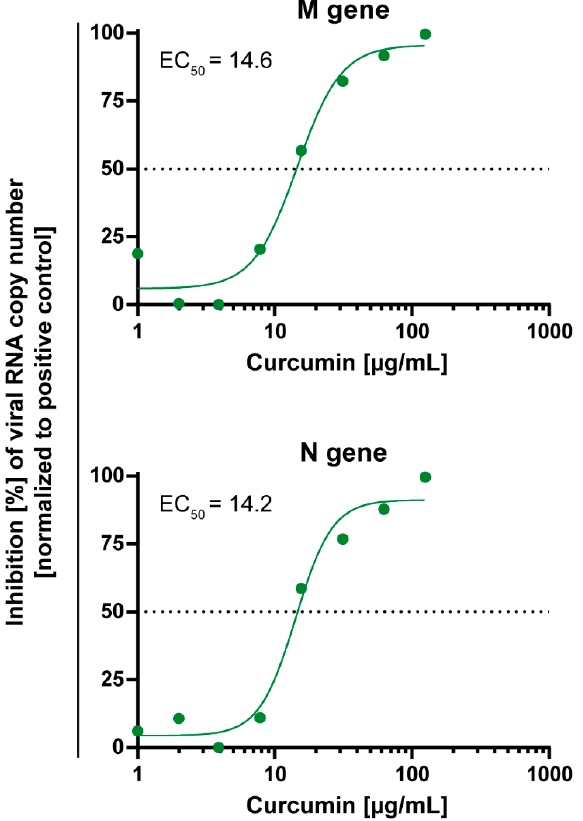
Figure 4. Dose-dependent activity of curcumin on SARS-CoV-2 RNA genome copy numbers. Decreasing concentrations of curcumin (125–1 µg/mL) were pre-incubated with 100 TCID 50 of SARS-CoV-2 for one hour and subsequently added to confluent Vero E6 cells. After 48 h, cell culture supernatants were harvested, and the genomic SARS-CoV-2 RNA was quantified via RT-qPCR, using primer targeting the viral M or N gene. Cells infected with 100 TCID 50 of SARS-CoV-2 served as positive control. The experiment was performed three times independently. The half-maximal effective concentration (EC 50 ) was calculated by nonlinear regression using GraphPad